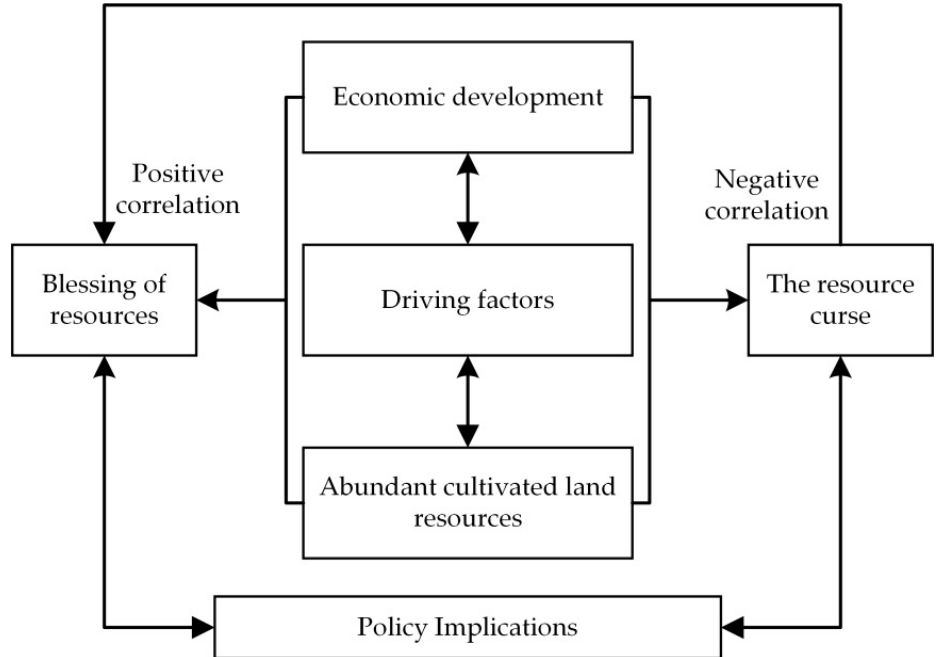
Figure 2. Connotation between abundant cultivated land resources and economic development.